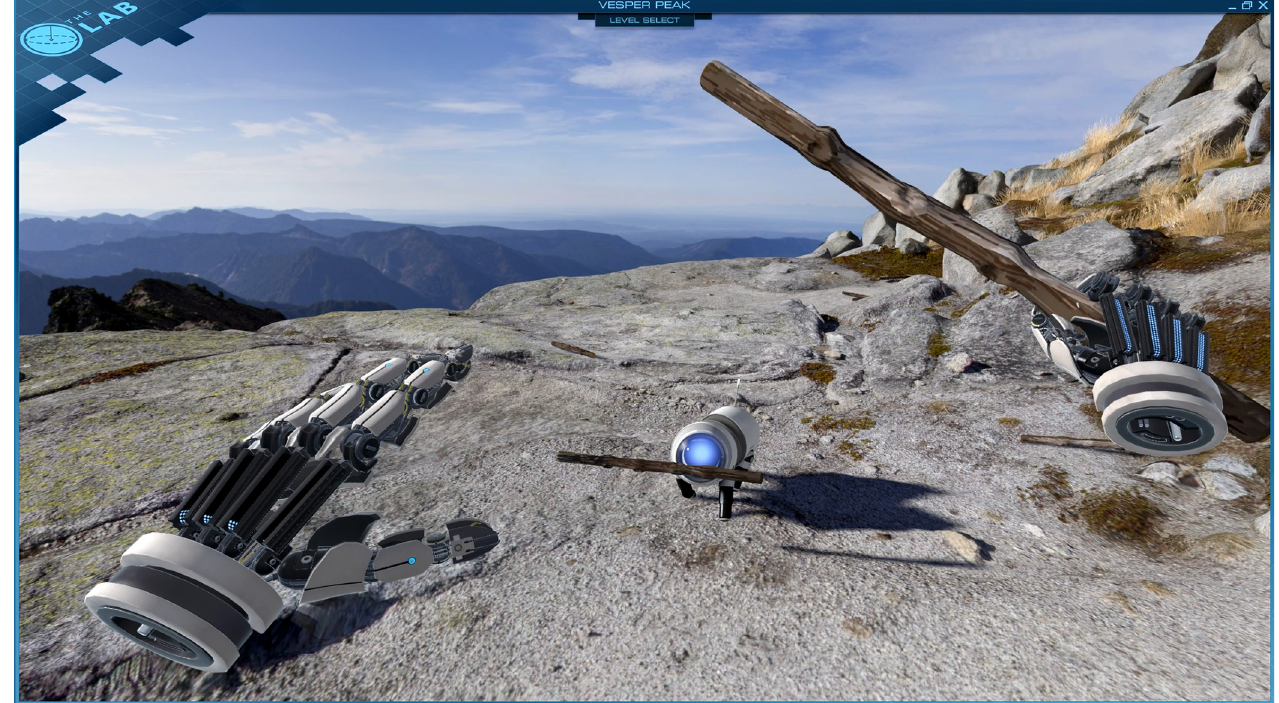
Fig 3. Virtual environment “Vesper Peak” used for iVR calibration and training.